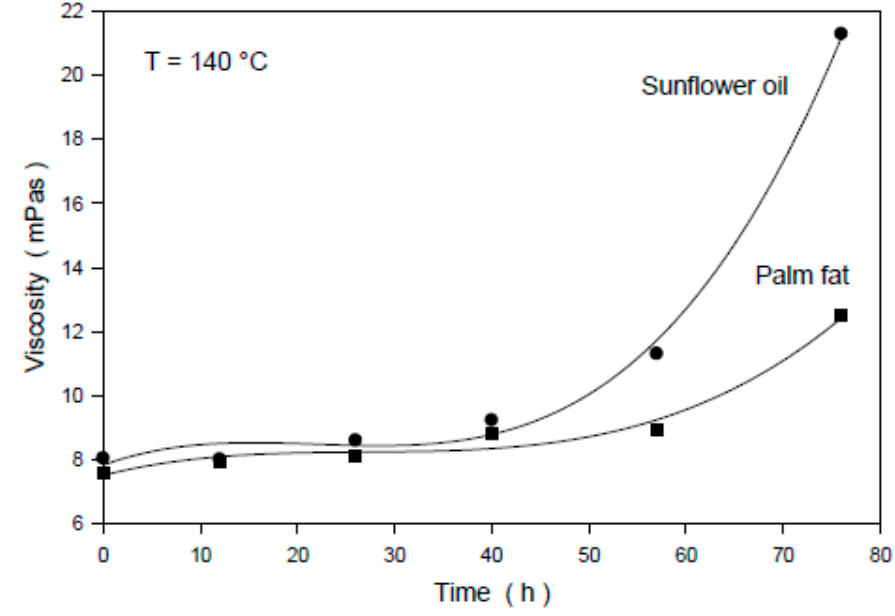
Figure 3. Dependence of the dynamic viscosity of sunflower oil and palm fat on the time of thermo- oxidative treatment; measuring temperature: 140 °C; shear rate: 1872 s − 1